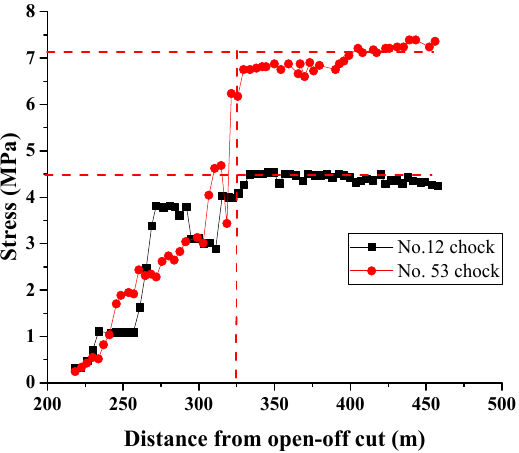
Figure 15. Stress variations with the working face advancement.